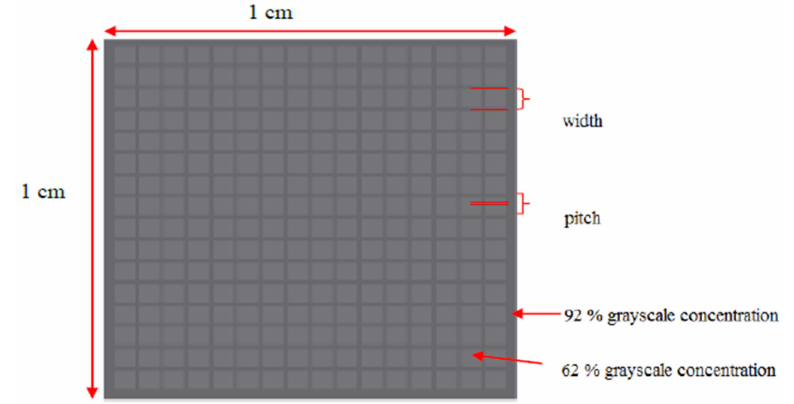
Figure 2. Zoomed in software-designed mask design